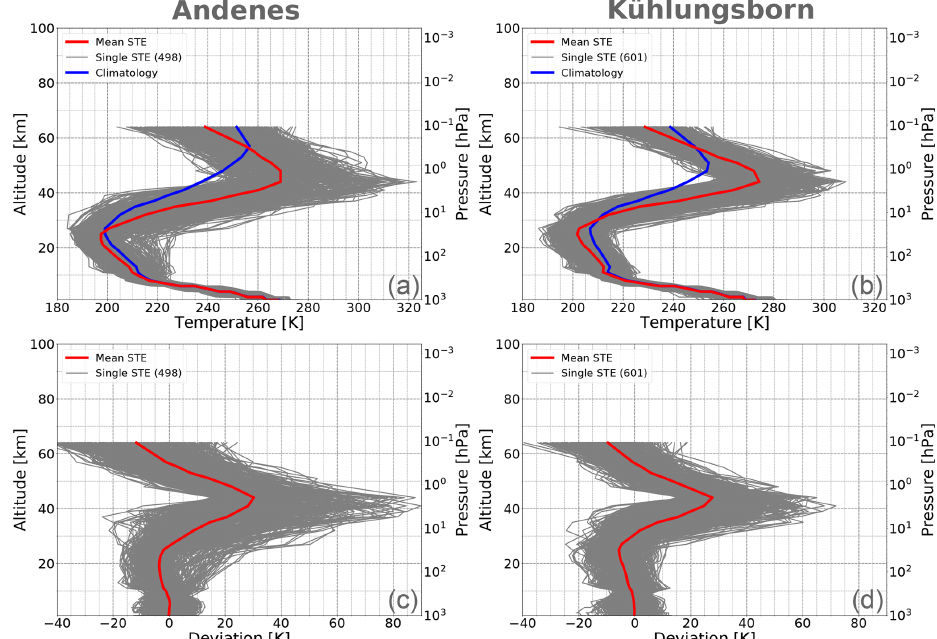
Figure 3. (a, b) Vertical profiles (grey) of all STEs between winter 1980/81 and 2018/19 in MERRA-2 data at Andenes and Kühlungsborn and their respective mean (red line). The blue line represents the climatology over all winter profiles. (c, d) Same as in the top row but climatology (blue line) is